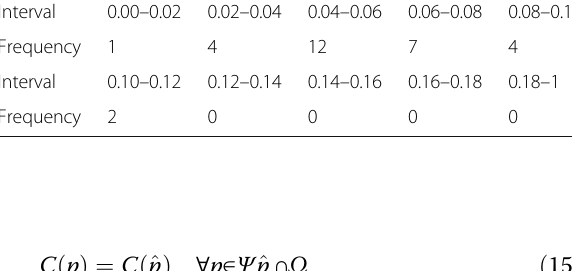
Table 2 Normalized similarity distance statistics